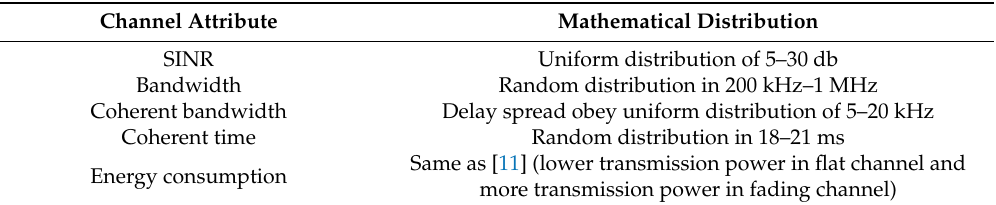
Table 2. The distributions of each channel attribute.